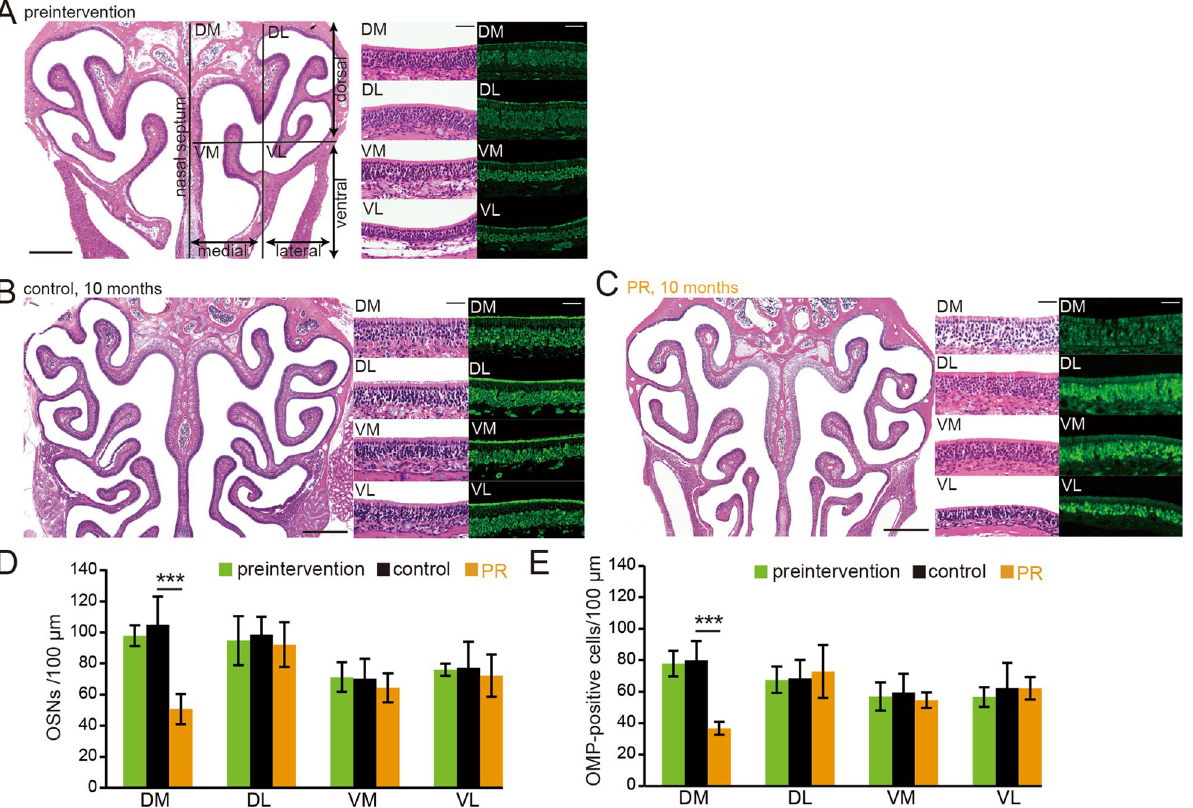
Figure 3. PR induces OE injury in the dorsomedial area of the OE. ( A – C ) Photomicrographs of representative coronal sections of the olfactory epithelium (OE) in preintervention mice ( A ), control mice ( B ), and PR mice ( C ). The unilateral OE was divided into four areas: dorsomedial (DM), dorsolateral (DL), ventromedial (VM), and ventrolateral (VL). Left images, low magnification; middle (HE-staining) and right images (anti- OMP staining), high magnification. Scale 300 µm at low magnification, 50 µm at high magnification. ( D , E ) Numbers of OSNs ( D ) and numbers of OMP-positive cells ( E ) in each area (DM, DL, VM, and VL). Significant histological changes in each area were observed between preintervention and control mice, while a significant difference between control mice and PR mice was detected only in the DM area (***P < 0.001, Mann–Whitney